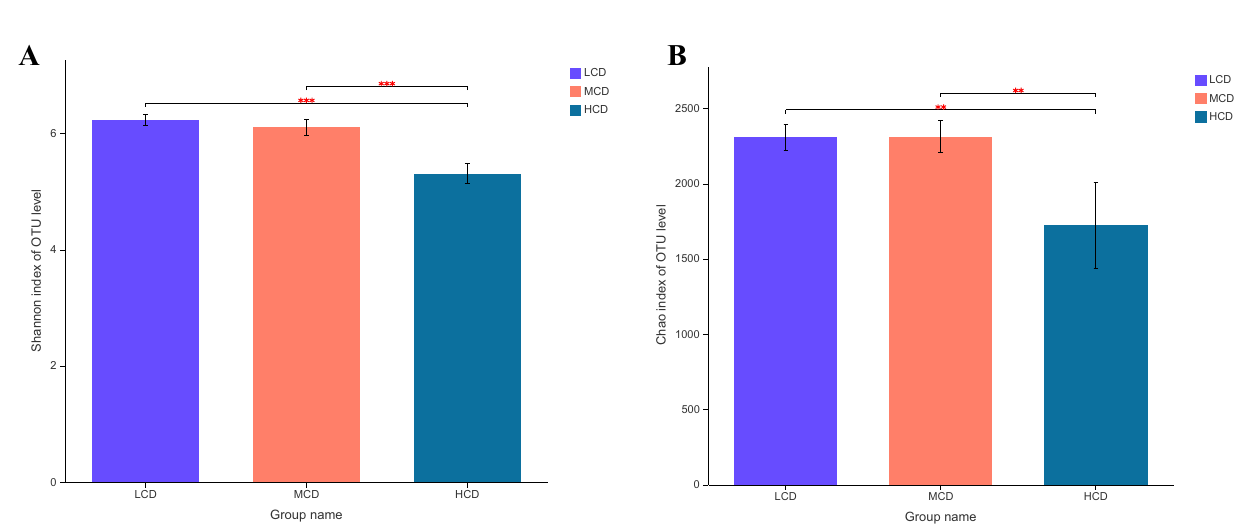
Figure 1. Differences in ruminal bacterial diversity and richness between cows fed diets with different forage to concentrate ratios. Bacterial diversity was estimated by Shannon index ( A ). Bacterial richness estimated by the Chao1 value ( B ). LCD, 35:65 concentrate:forage; MCD, 50:50 concentrate:forage; HCD, 65:35 concentrate:forage; Asterisks indicate significant difference between the groups (P <